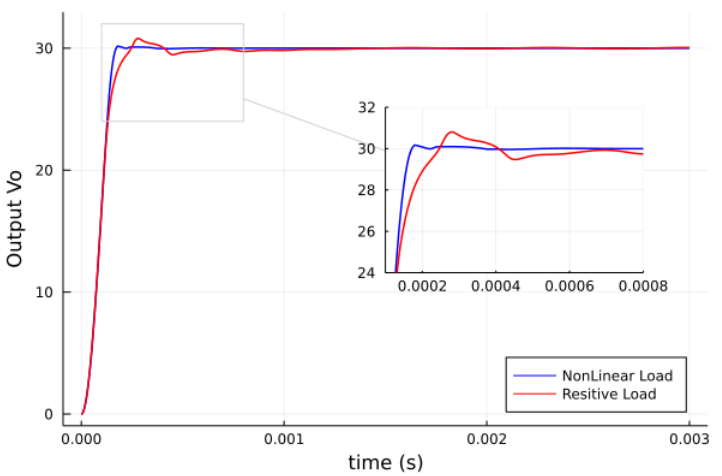
Figure 12. The output responses for the resistive load and for the nonlinear load.